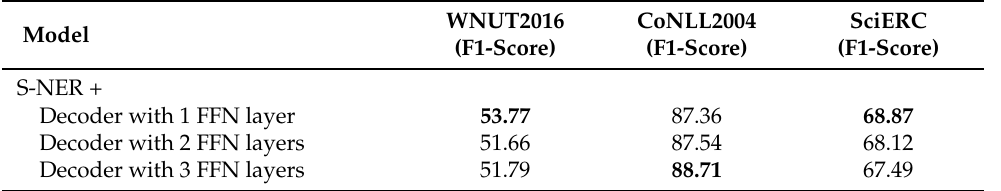
Table 6. Performance against the model decoder with various FFN layers, which is evaluated on the dev sets of the three benchmark datasets. Bold values denote the best